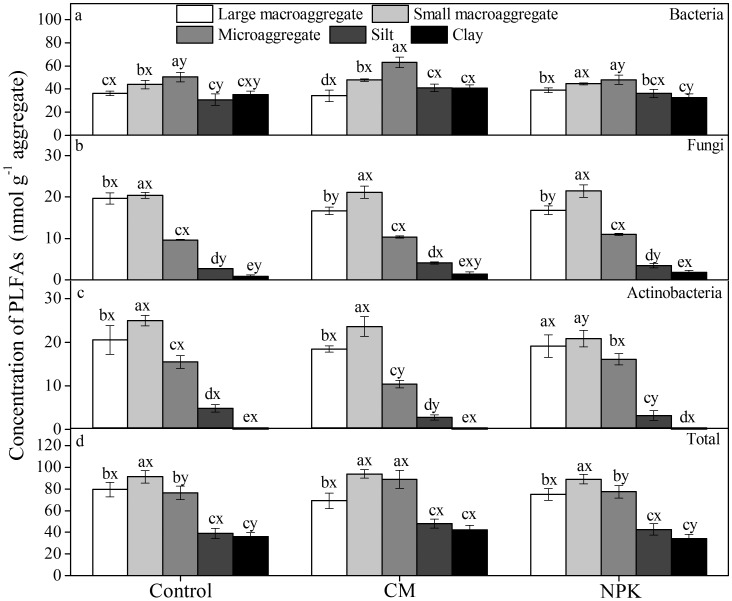
Effect of long–term applications of fertilizer NPK and compost on concentrations (nmol g–1 aggregate) of bacterial, fungal, actinobacterial and total PLFA in aggregates.Values are means (n = 4) with standard error. Different letters denote significant differences between aggregates with the same treatment (a, b, c, d, e) and between treatments with the same aggregate (x, y, z) at P<0.05, respectively.